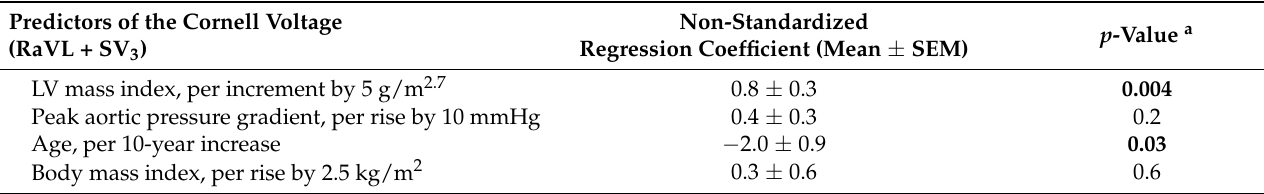
Table 5. Multiple regression analysis of predictors associated with the Cornell, Sokolow–Lyon, Romhilt and Gubner– Ungerleider voltage criteria for LVH with LV mass indexed to height 2.7